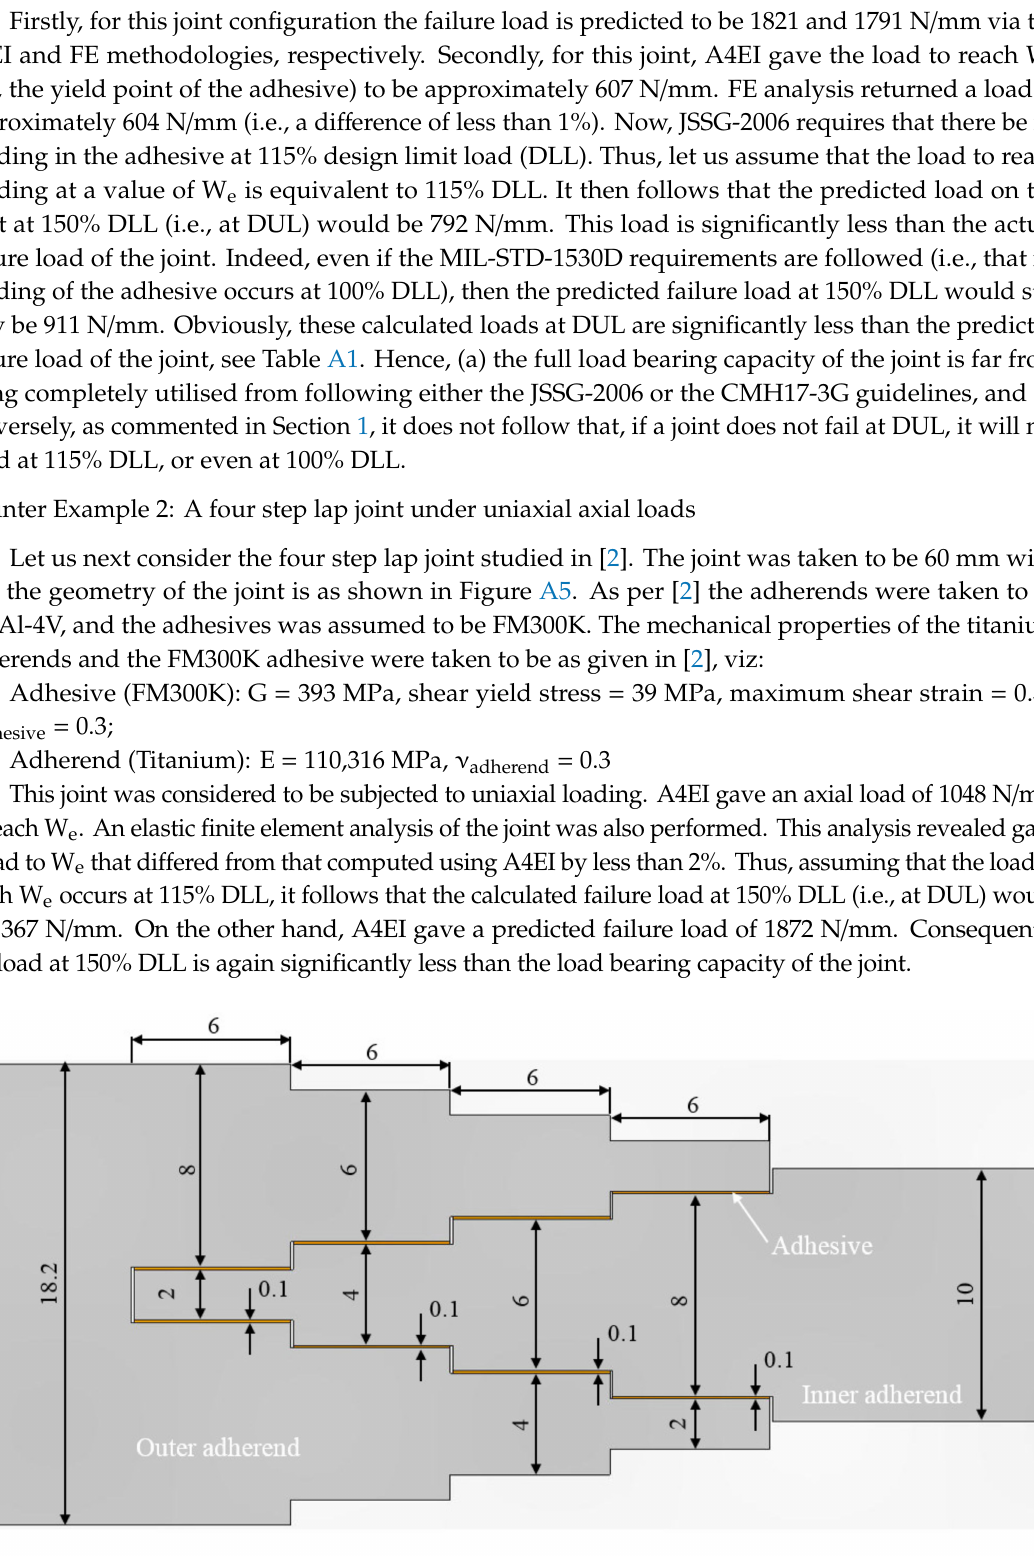
Figure A5. Schematic diagram of the cross-section of the four-step bonded joint studied in [2], dimensions are in